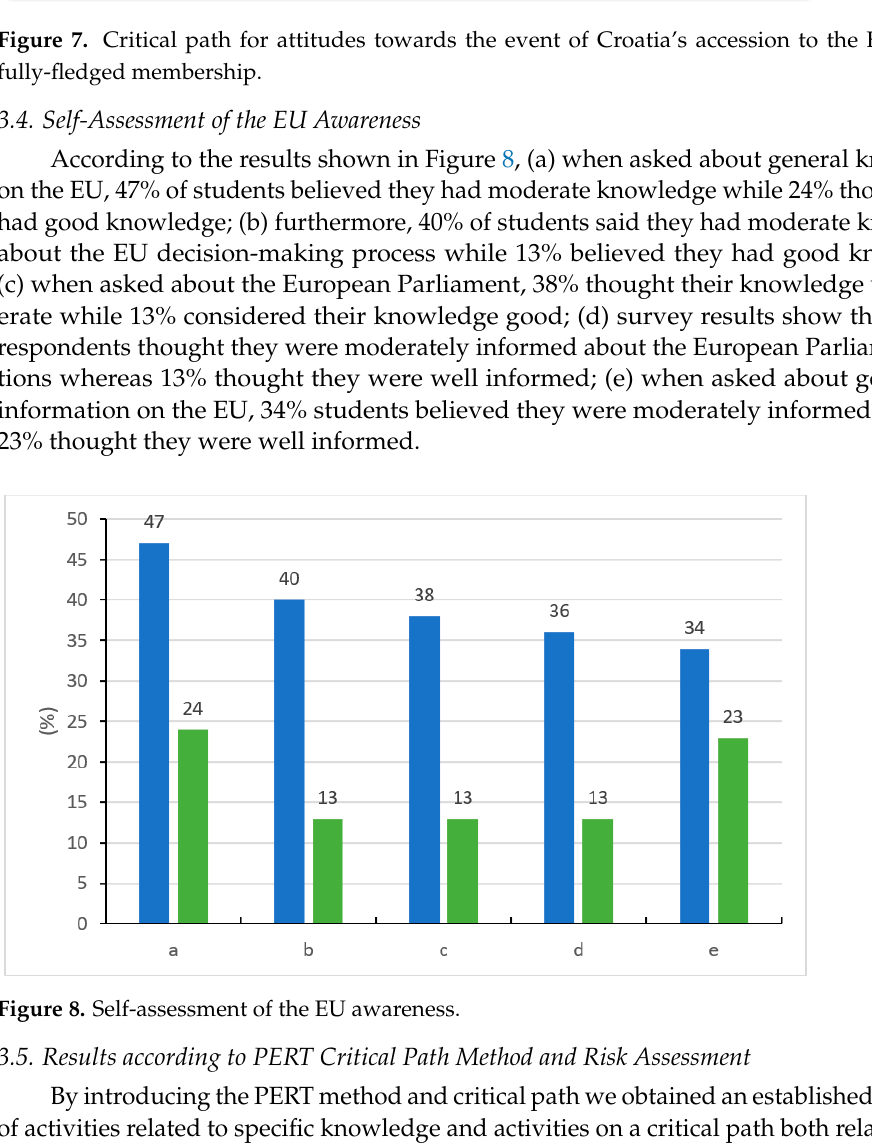
Figure 8. Self-assessment of the EU awareness.